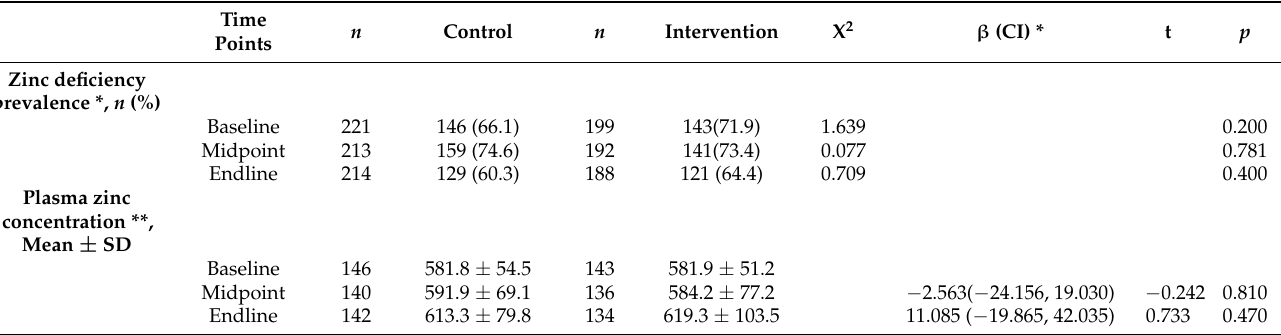
Table 5. Zinc deficiency prevalence for all participants ( n = 420) and plasma zinc concentration of subgroup with zinc deficiency at baseline ( n = 146) over time by study